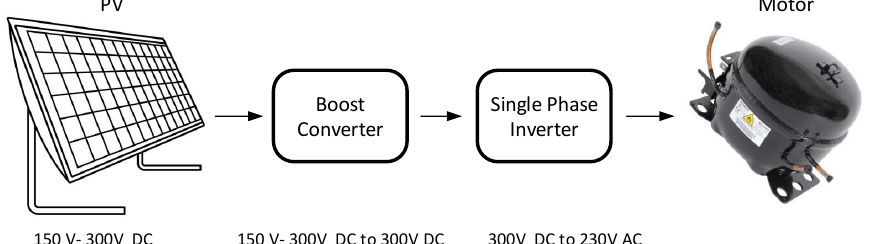
Figure 1. The schematic of the proposed PV